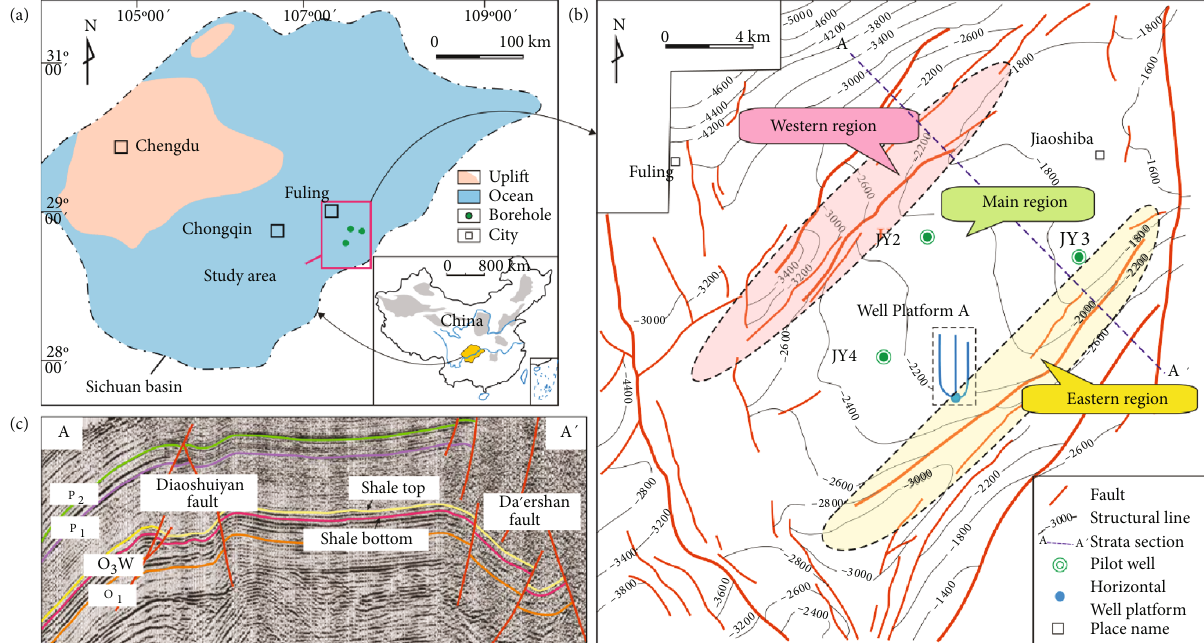
Figure 1: Study area location and structural characteristics. (a) The location of the Fuling shale gas fi eld in the Sichuan Basin, China. Modi fi ed from Ref. [29]. (b) The structural map of the Fuling area, showing the strata incline to the southwest generally. Modi fi ed from Ref. [36]. The Fuling shale gas fi eld was divided into three regions: eastern, western, and main, according to the structural and development characteristics [37]. (c) Seismic pro fi le across the Fuling shale gas fi